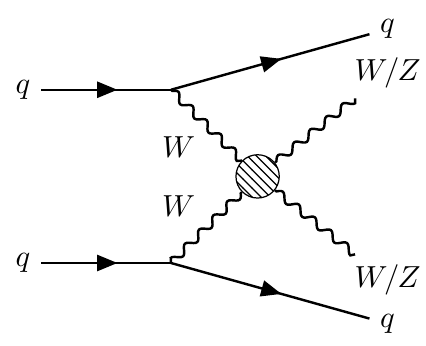
Figure 9 . Example Feynman diagram for the contribution of aQGCs to the qq qq qqZZ !